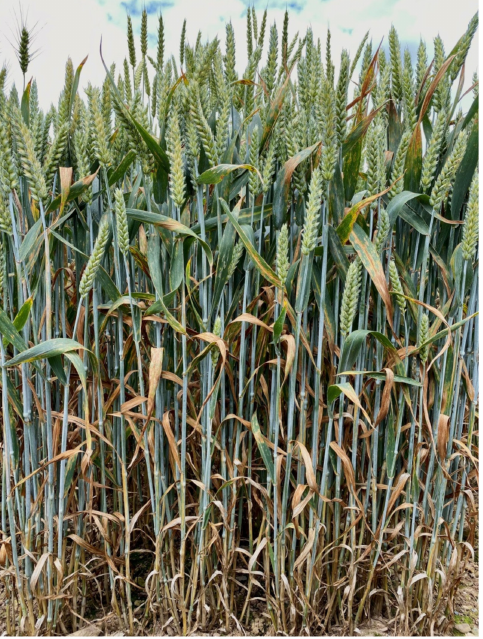
Figure 1. Septoria tritici blotch (STB) disease of wheat in a field trial in Carlow, Ireland, showing the resulting necrosis of the leaves within the crop